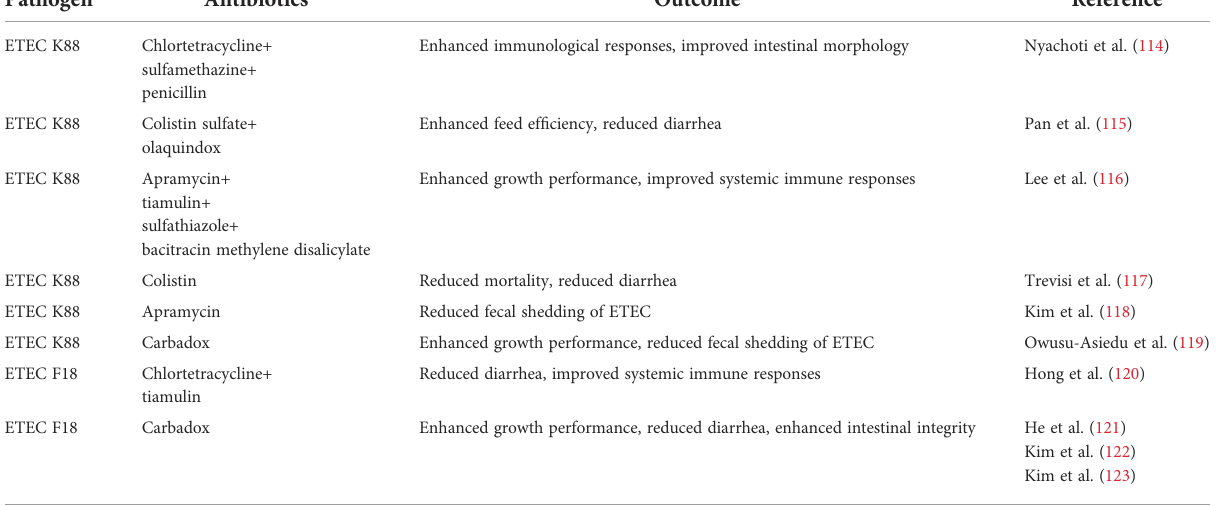
TABLE 2 In-feed antibiotics on ETEC infection of weaned pigs.